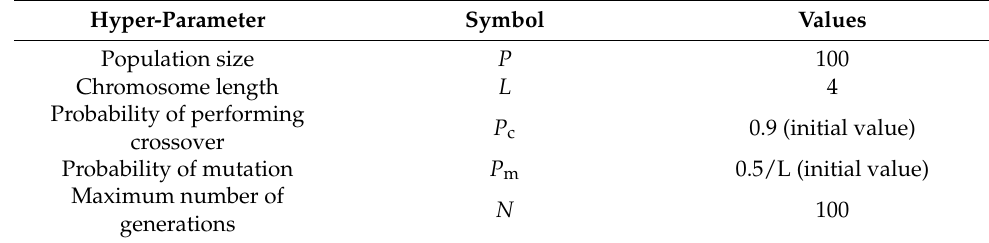
Figure 5. Soft sensing results of VCM using three RBFNN based methods under different cluster number ( a ) 15 clusters ( b ) 20 clusters ( c ) 25 clusters ( d ) 30 clusters ( e ) 35 clusters ( f ) 40 clusters.